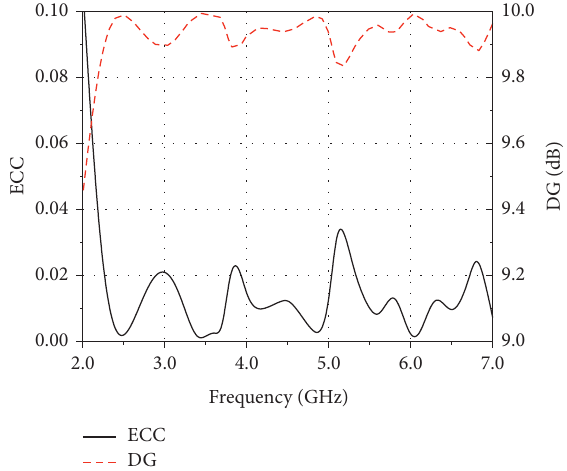
Figure 9: Measured ECC and DG results of the proposed MIMO antenna.